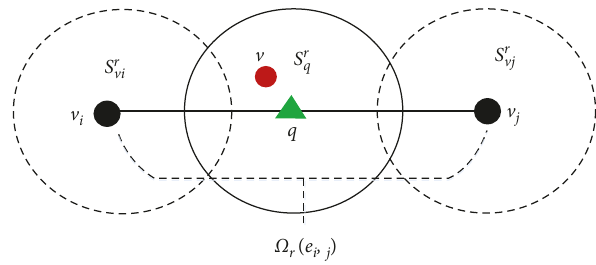
Figure 8: Illustration of Theorems 2 and